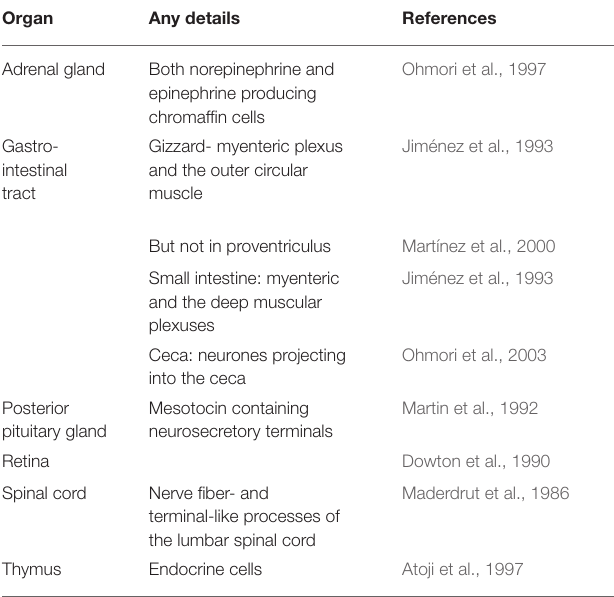
TABLE 1 | Cells containing immuno-reactive Met-enkephalin in chicken